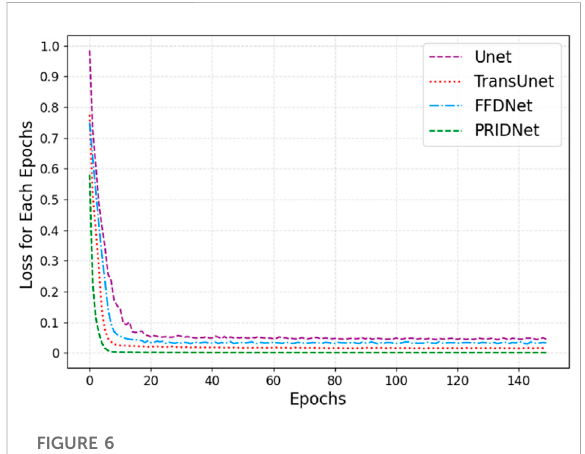
FIGURE 6 The neural network training curves for four denoising models which are Unet, TransUnent, FFDNet, and PLMF-net.